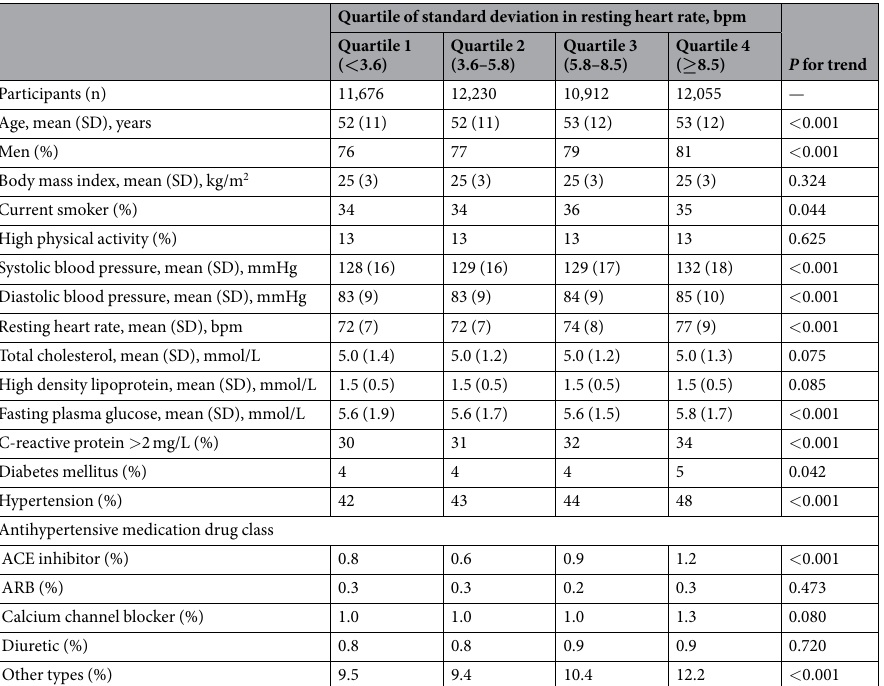
Table 1. Clinical characteristics of participants divided by quartiles of standard deviation in resting heart rate * (n = 46,873). * Assessed using data at the 3 rd examination in the Kailuan Study (2010–2011). Continuous variables were presented as mean (SD). Categorical variables were expressed as percentages. bpm: beats per min. Differences between different heart rate quartiles at baseline were assessed using x 2 test for categorical variables and one-way ANOVA for continuous